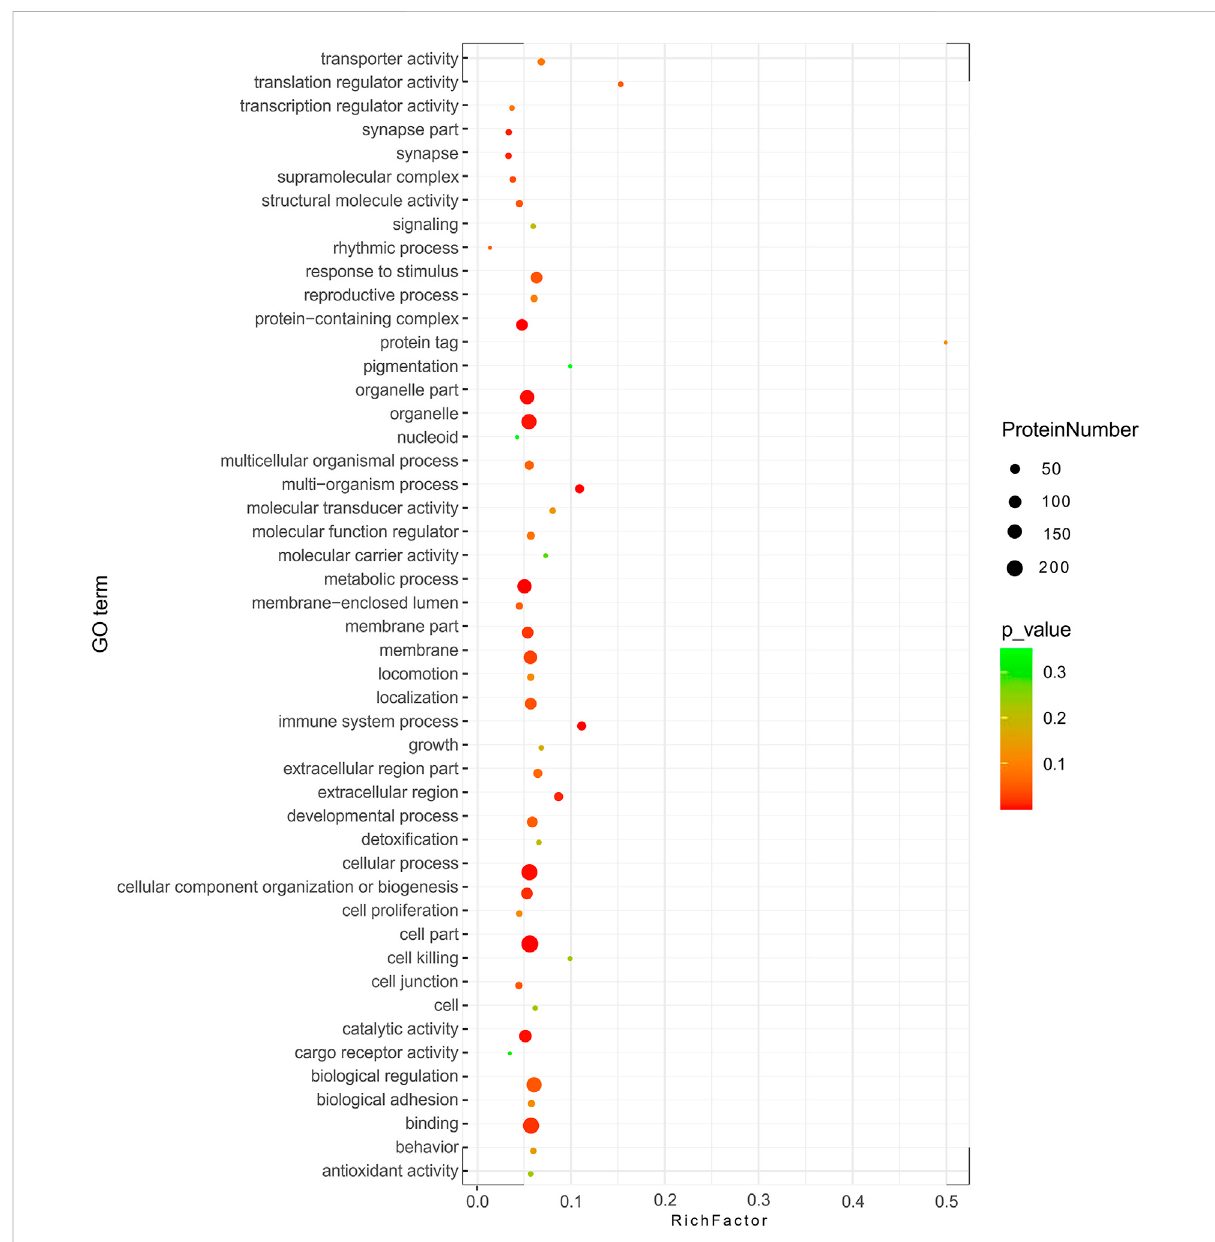
FIGURE 5 KEGG enrichment bubble chart for the differential proteins-involved